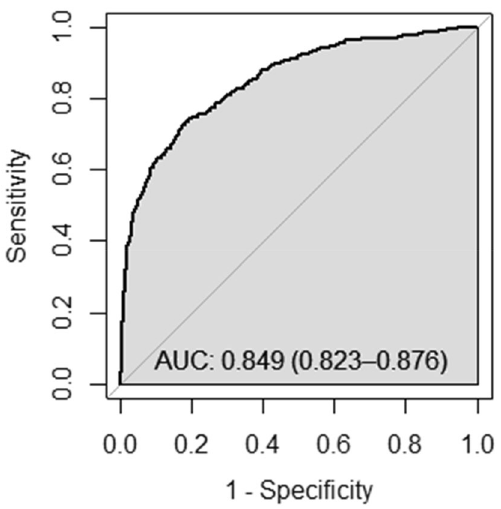
Figure 3. Receiver operating characteristic analysis for the accuracy of FIB-4 to diagnose cirrhosis (transient elastography ≥ 12.5 kPa) in patients with hepatitis C infection (n = 906).